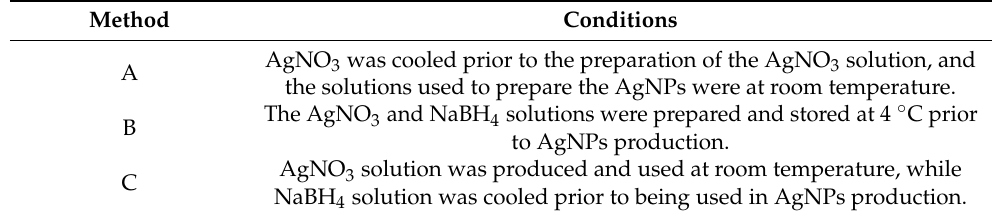
Table 5. Temperature of the solutions used for AgNPs production following methods A, B and